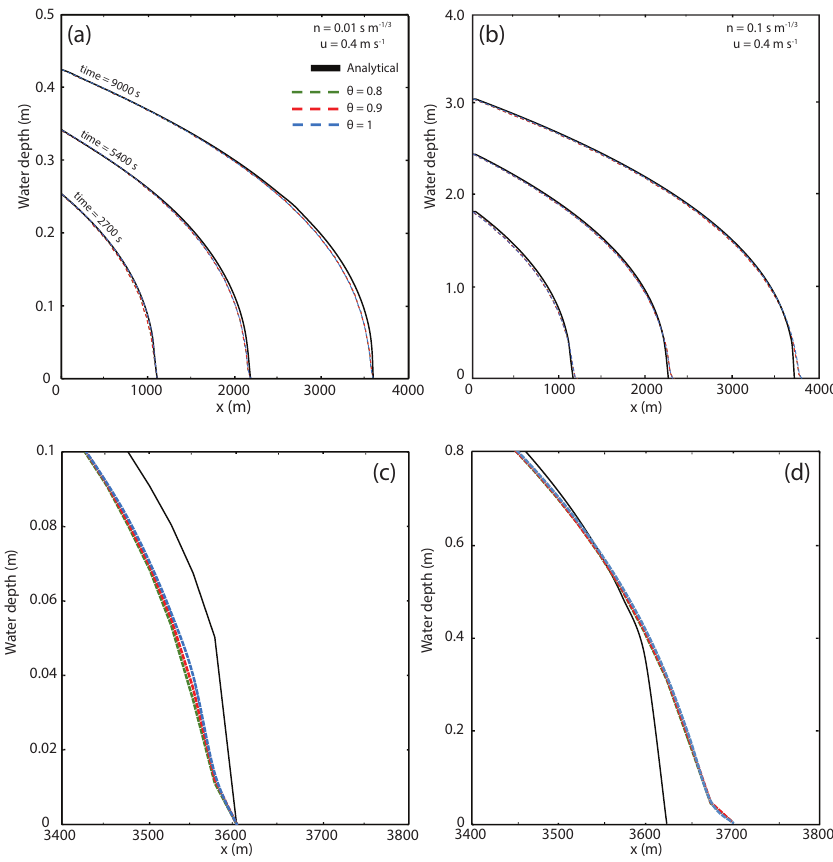
Figure 7. Sensitivity of the Landlab OverlandFlow component with a changing Manning’s n , compared to the analytical solution. This figure is illustrated in the same manner as Fig. (2) from de Almeida et al. (2012). Water depth was plotted against distance for two combinations of velocity and friction coefficient values. Both panels (a) and (b) show water depths for t zoomed-in images of the wave fronts from panels (a) and (b) , respectively, at time